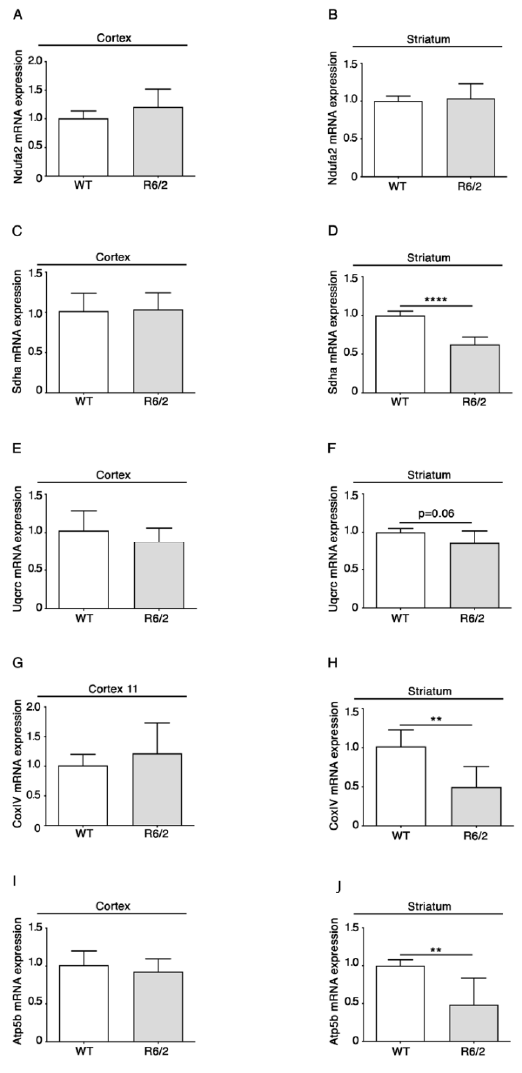
Figure 1. Altered RNA levels of components of the nuclear-encoded ETS and ATP-synthase in brains of 11-week-old R6/2 mice. qPCR analysis of both cortical and striatal Ndufa2 ( A , B ), Sdha ( C , D ), Uqcrc ( E , F ), Cox IV ( G , H ), Atp5b ( I , J ) are presented. N = 5/6 for each group of mice. Data are represented as mean ± SD. ** p < 0.01, **** p < 0.0001 (Unpaired t -test). The raw data used for generating the figure are reported in the Supplementary Materials Table S1.